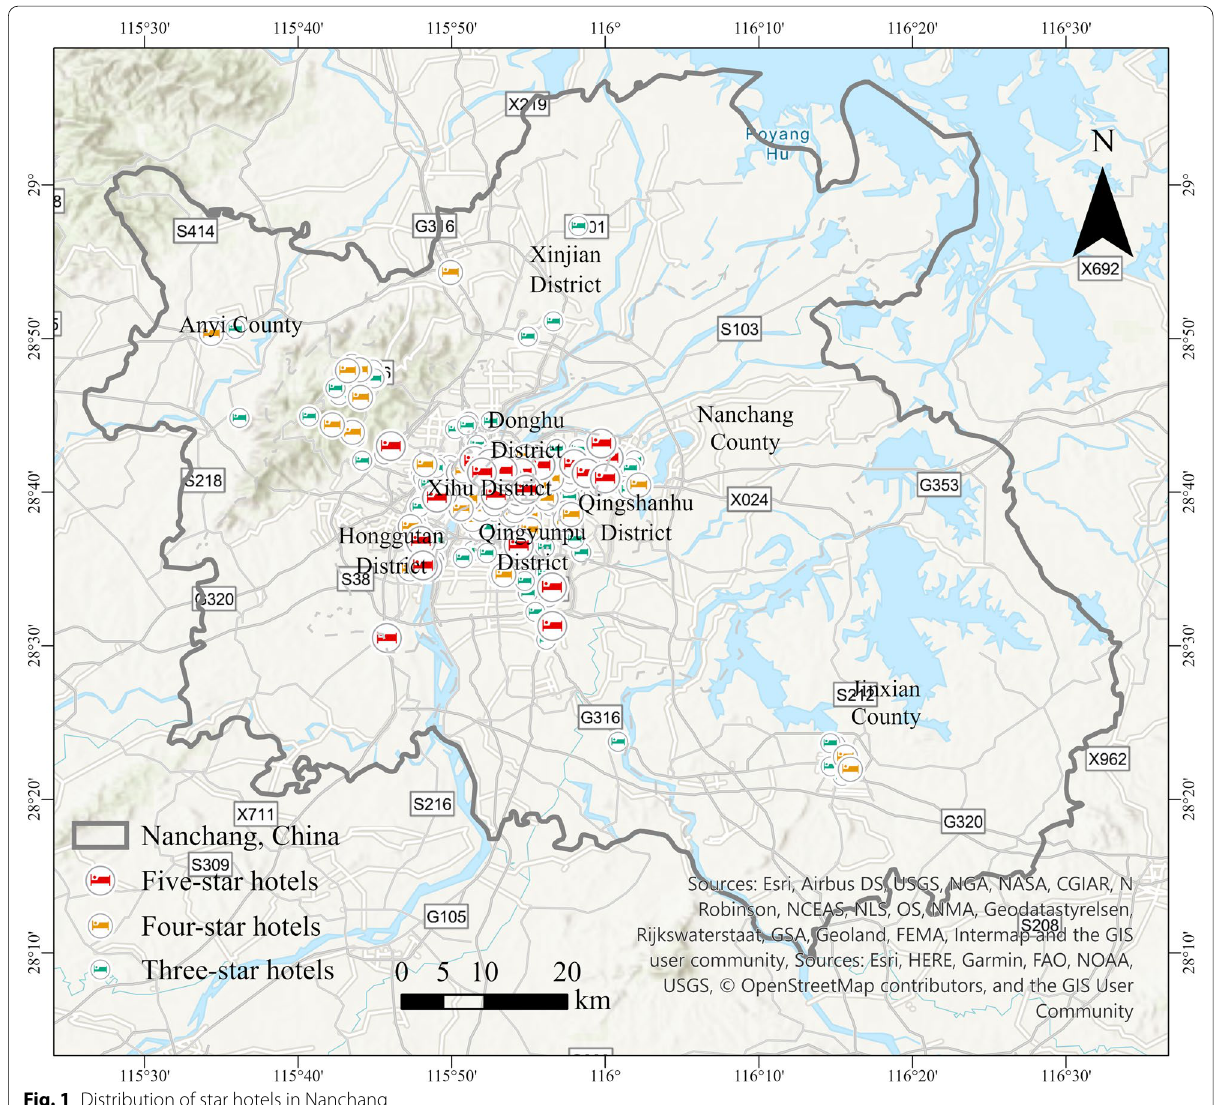
Fig. 1 Distribution of star hotels in Nanchang